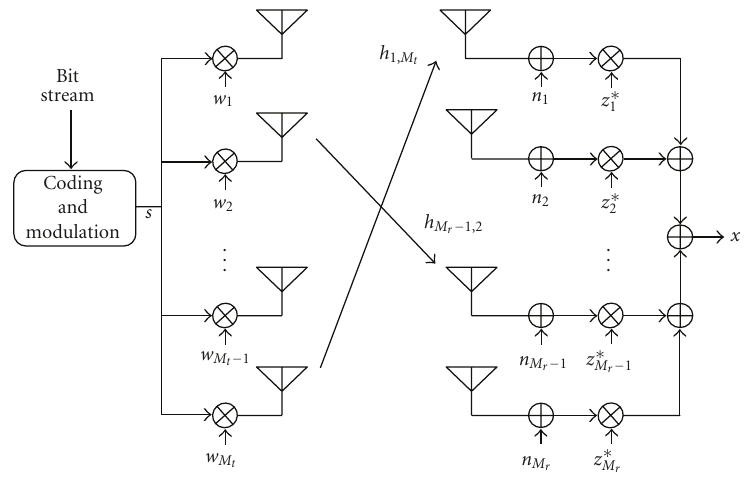
Figure 2: MIMO block diagram (see [6, datapath portion of Figure